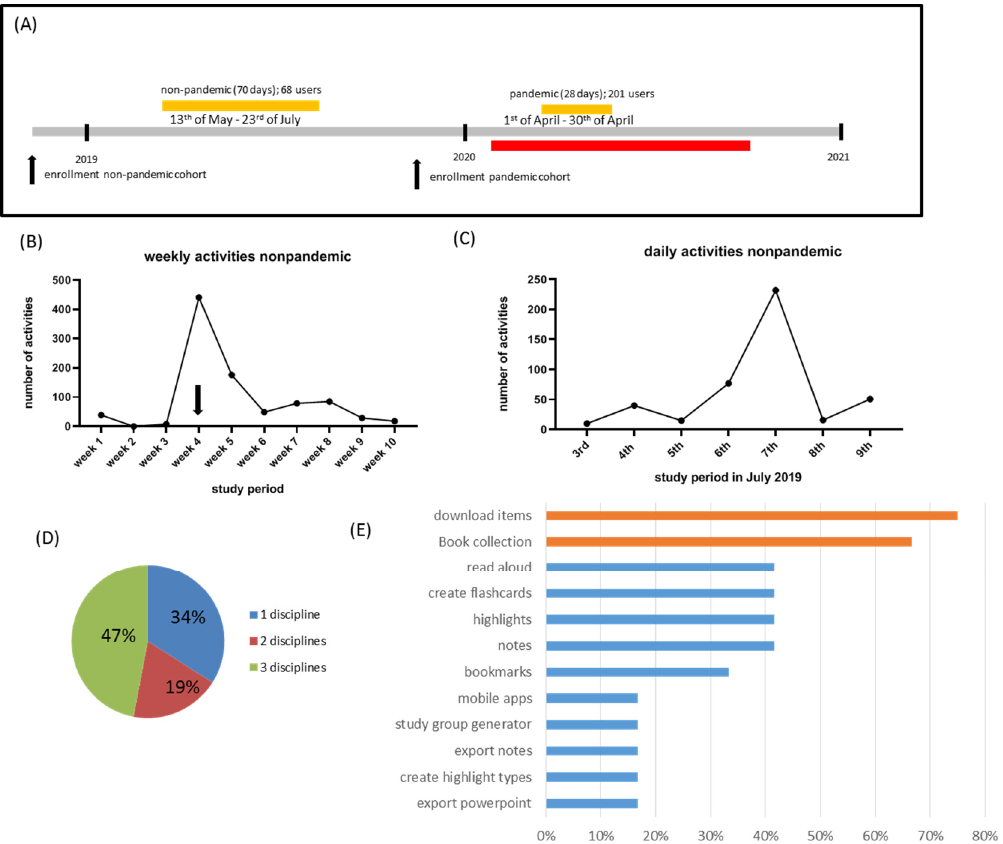
Figure 1. E-learning platform acceptance during the non-pandemic study period. ( A ) demonstrates the basic organization of the study. Yellow bars highlight the non-pandemic (70 days) and pandemic (28 days) study periods. The red bar highlights the period of the COVID-19 lockdown. ( B ) Weekly activities during the non-pandemic study period. The arrow highlights peak activities at week 4, which are demonstrated in ( C ) on a daily basis (i.e., from 3 until 9 July 2019). ( D ) demonstrates the percentage of users using items from one, two or three different medical disciplines. ( E ) shows survey results of the non-pandemic cohort regarding the acceptance of different e-learning platform functions among the participating